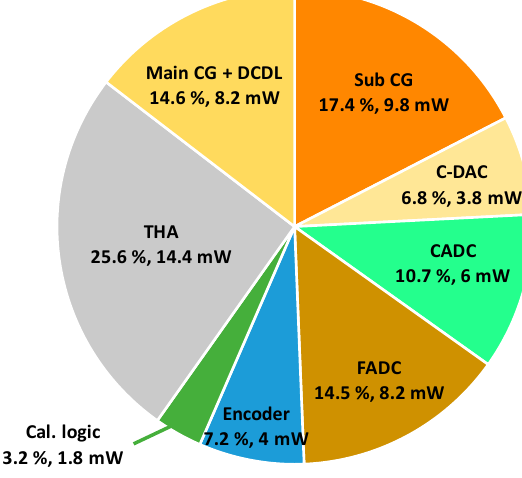
Figure 19. Power